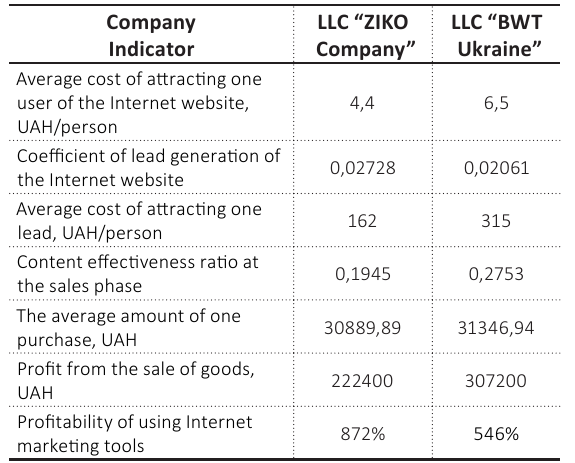
Table 2. The results of calculations of the effectiveness of interaction with clients of LLC “ZIKO Company” and LLC “BWT